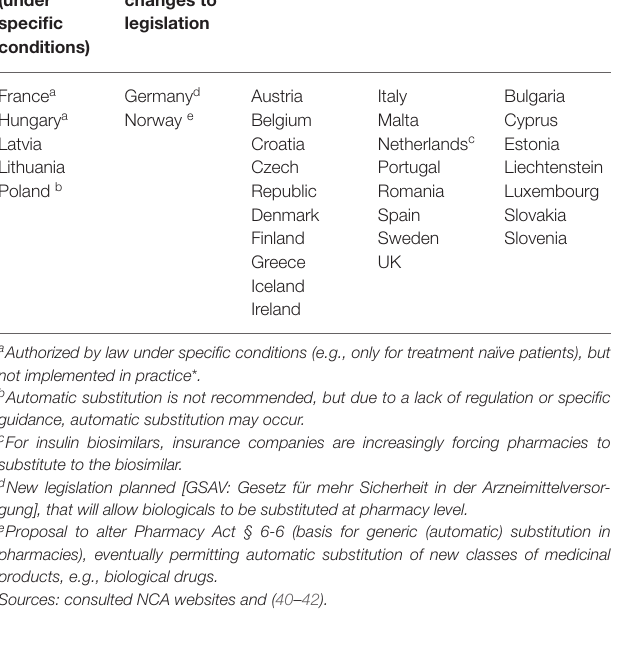
Allowed (under specific